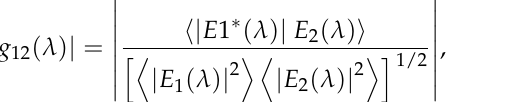
Figure 6. ( a , b ) Evolution of pulses at different positions of 2.5 m ND TMF; ( c , d ) Evolution of single pulse after different ND and AD zones of optimized CSAD-TMF.